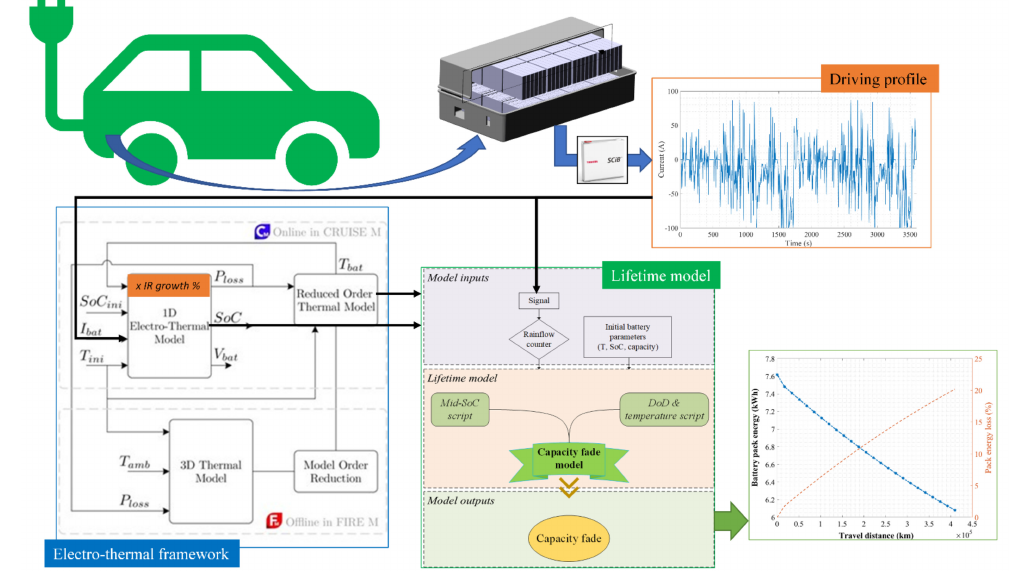
Figure 7. The overall electro-thermal-aging coupling